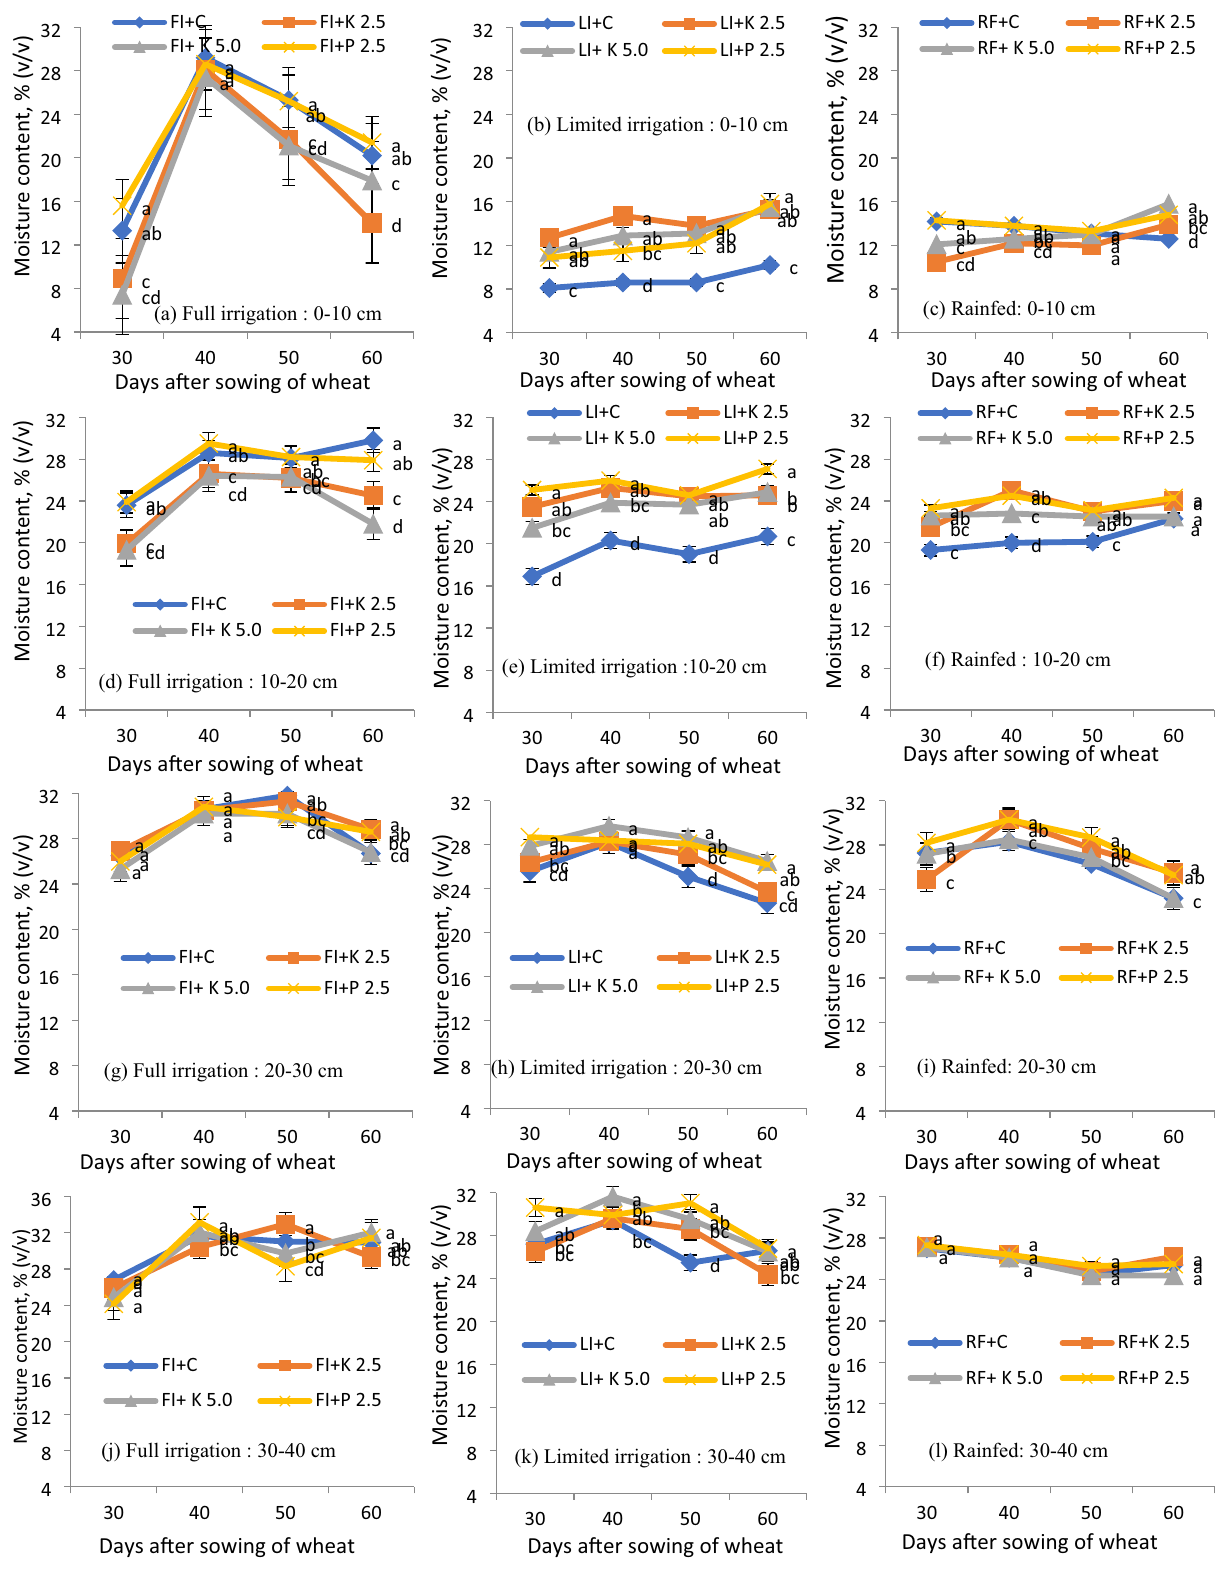
Figure 5. Volumetric water content (v/v) in wheat under different hydrogels and moistures stress conditions at 0–10 ( a–c ), 10–20 ( d–f ), 20–30 ( g–i ) and 30–40 ( j–l ) cm soil depths during 2018–19. Bars indicate standard error of mean. FI full irrigation, LI limited irrigation, RF rainfed, gel hydrogel. Means followed by a similar superscript letter within a column are not significantly different (at P ≤ 0.05) between treatments allowing to least significant difference